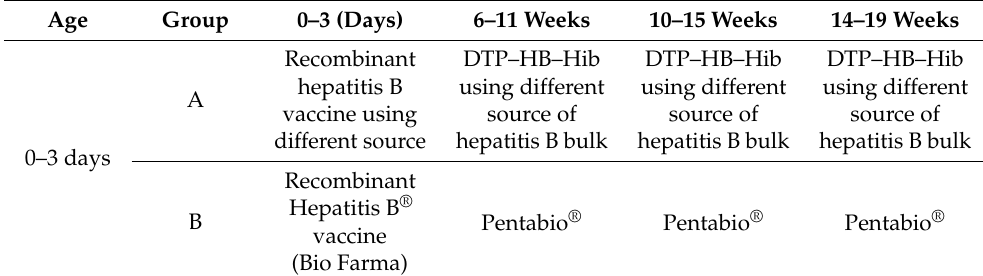
Table 1. Vaccines per intervention